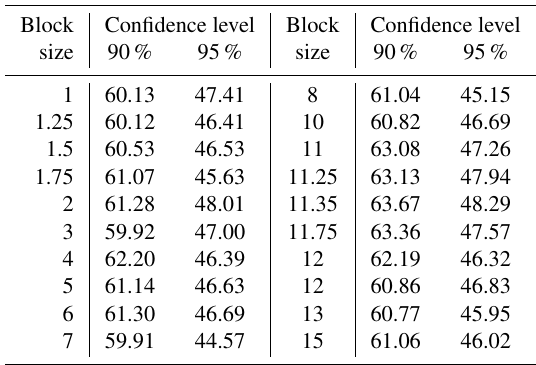
Table 3. The power of the homogeneity test (%). Null hypothesis: the VAR(1) process of Budapest and Apatovac ( H 0 ) for block size 8.71; against the VAR(1) process simulated with coefficient matri- ces e A and e C as alternative hypothesis.